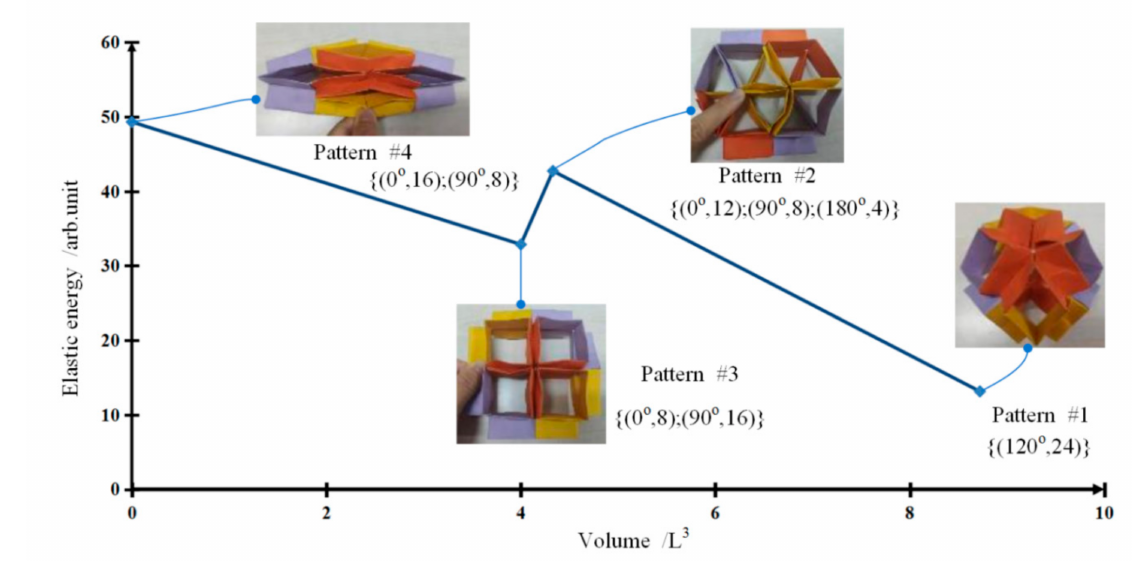
Figure 3. Shape shifting, energy landscape and cavity volume of rhombic dodecahedron origami.